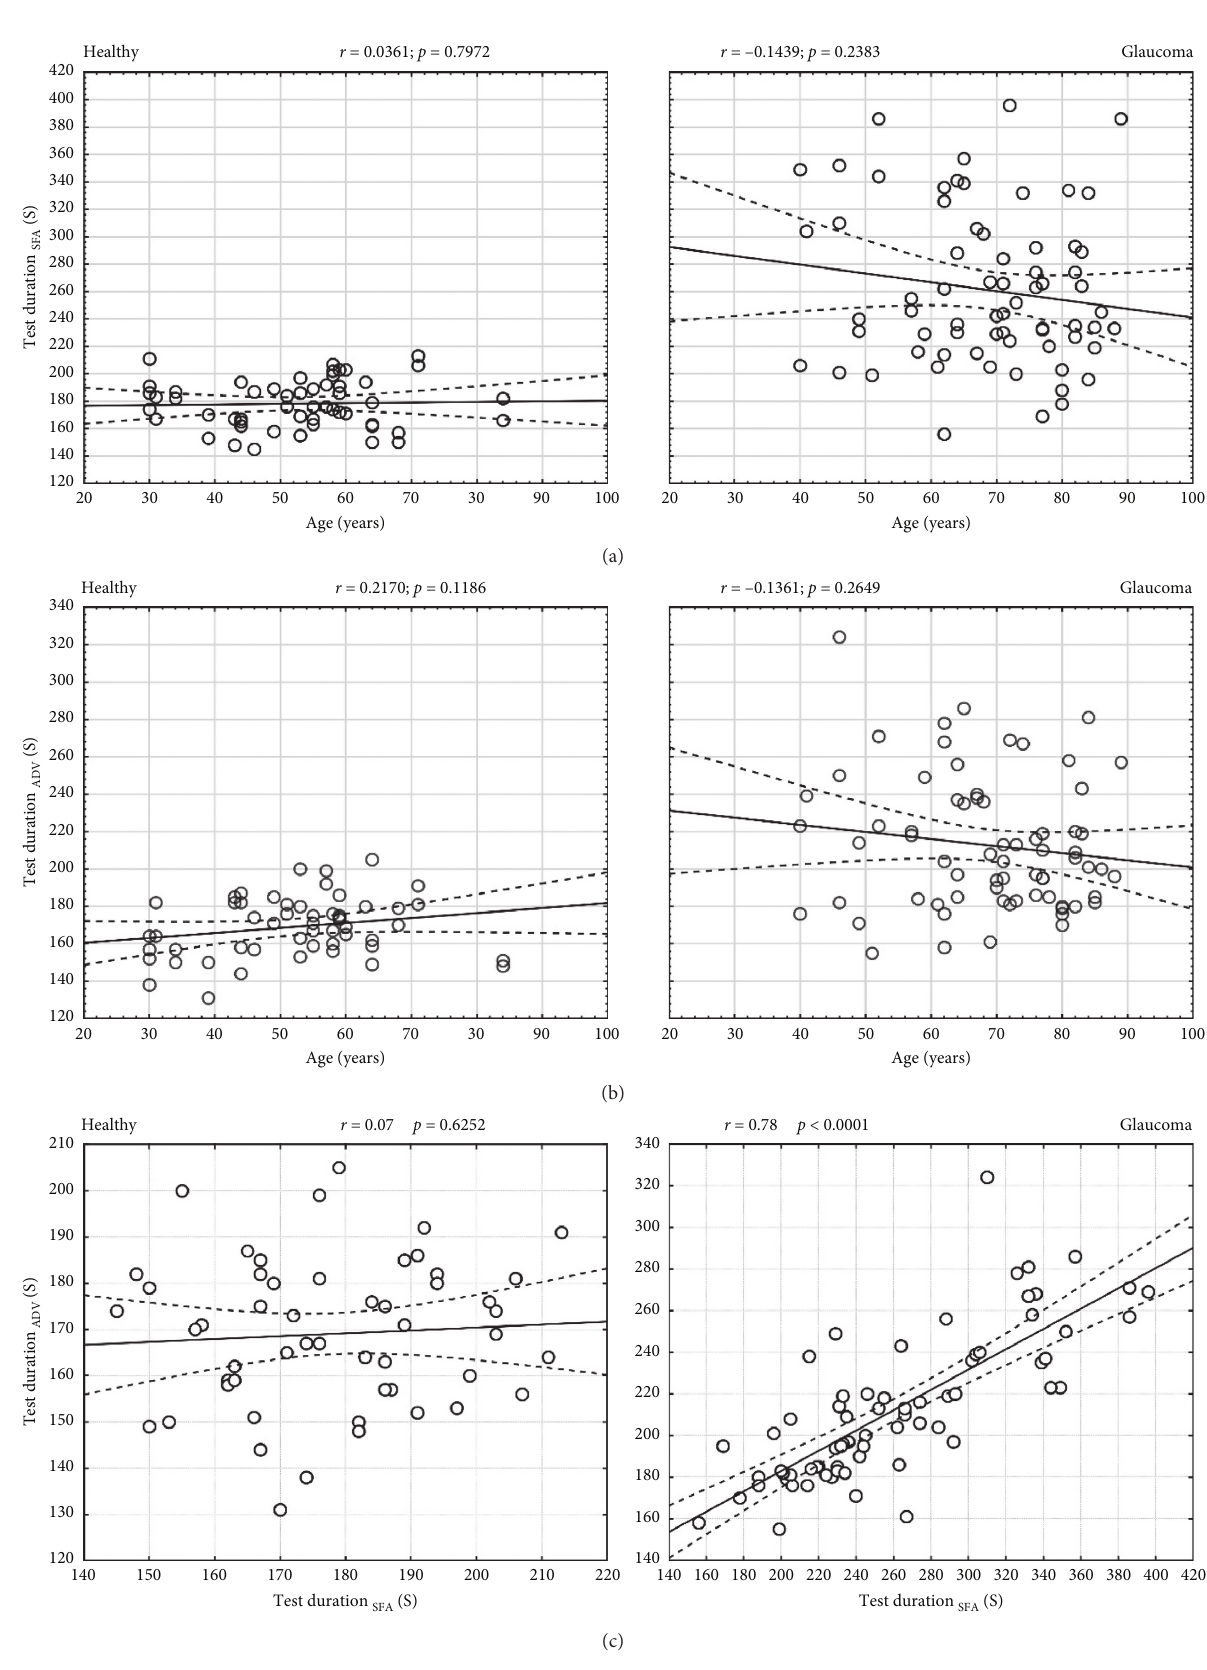
Figure 2: Test duration analysis in healthy and glaucomatous eyes. (a, b) Correlation of test duration with patients’ age for SFA and ADV strategies; (c) correlation between test duration in ADV and SFA